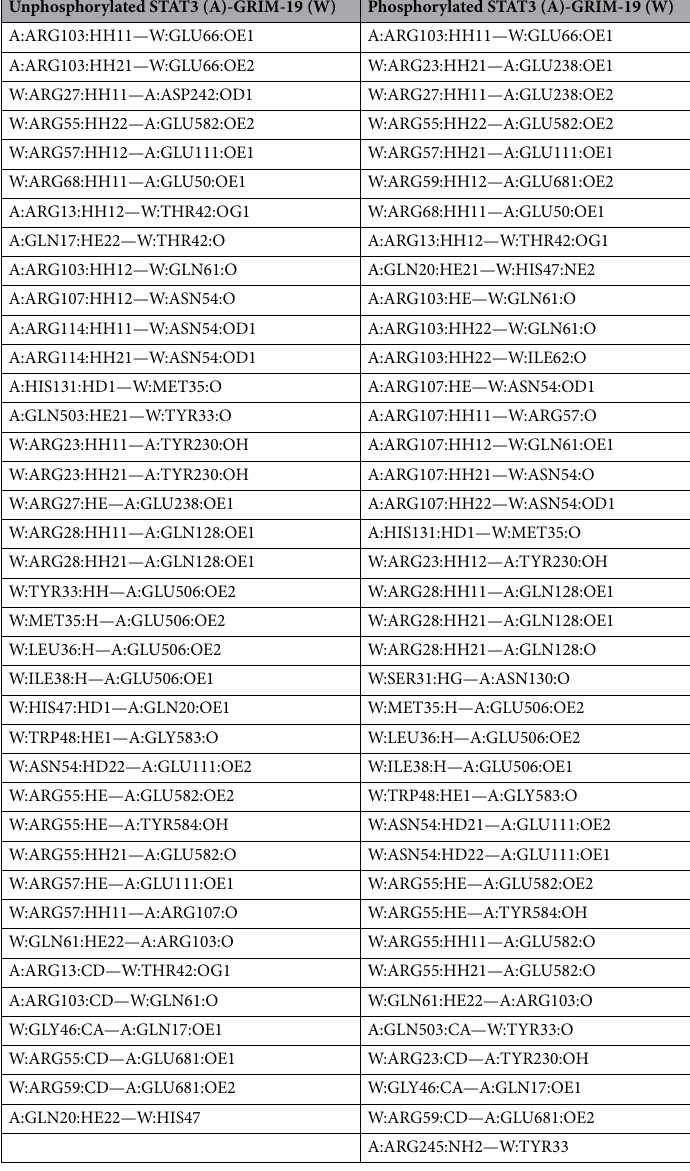
Table 2. AlphaFold2-generated STAT3 structure: Hydrogen bond interactions between STAT3 and GRIM-19 complexes generated by